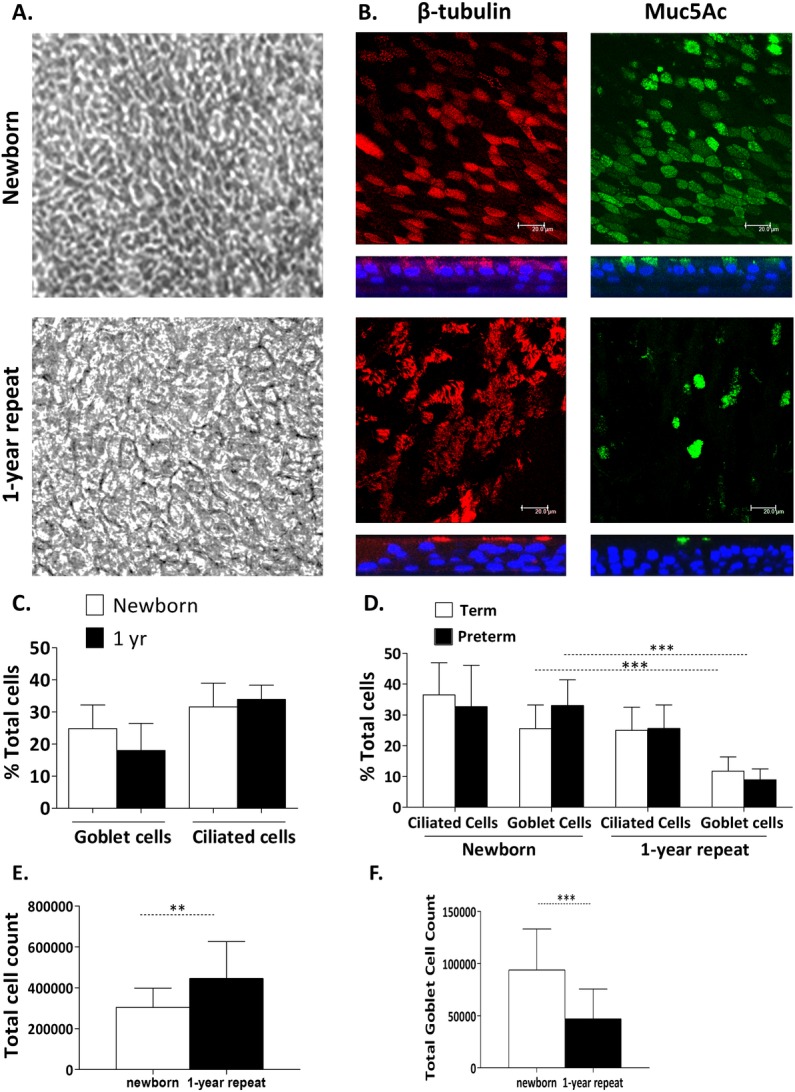
Morphology and differentiation status of birth and one-year repeat WD-PNEC cultures.Cultures were monitored by (A) phase-contrast microscopy (magnification x20) or (B) confocal microscopy after staining for β-tubulin (ciliated cell marker) (red), Muc5Ac (goblet cell marker) (green), or nuclei (DAPI) (blue). For (B), square panels represent en face images, whereas rectangular panels represent orthogonal sections, with the apical side at the top (magnification x63, with x1.5 digital zoom, bar = 20 μm). (C) Transwell cultures from birth and 1-year donors (n = 8 each) were fixed and stained for ciliated, goblet and total DAPI+ cells. Images from 5 fields/Transwell were taken at x60 magnification and ciliated, goblet and total DAPI+ cell numbers were counted using fluorescent microscopy. The % ciliated and goblet cells were determined relative to total DAPI+ cell numbers. (D) Representative preterm and term Transwell cultures (newborn term n = 9, preterm n = 10, one-year term n = 9, preterm n = 6 donors) were trypsinised, contents fixed onto slides by smearing or use of cytospin funnels, as described, and stained for ciliated (anti–β-tubulin), goblet (anti-Muc5Ac), and total DAPI+ cells. Ciliated and goblet cell numbers were expressed as mean (±SD) % proportion of total DAPI+ cell numbers for each cohort. *** unpaired t-test, p<0.0001. (E) Transwell cultures were trypsinized and total cell count performed by trypan blue exclusion using a haemocytometer. Total cell numbers are presented as mean (±SD) for newborn (n = 17) and 1-year cohorts (n = 15), p = 0.0087 (unpaired t-test of difference in means). (F) Combined total goblet cell numbers were determined for trypsinised representative Transwell cultures. Data plotted for newborn (n = 17) and 1-year (n = 15) cohorts as mean (±SD) for each culture cohort. ***unpaired t-test of difference in means, p = 0.0005.